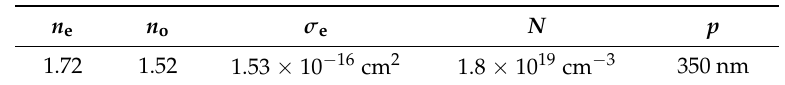
Table 1. Optical parameters used in the simulation for the active CLC (cholesteric liquid crystals) material. The density of dye molecules N corresponds to a proportion of 1 wt % of the DMC dye in an E7 matrix. p denotes the helical pitch.